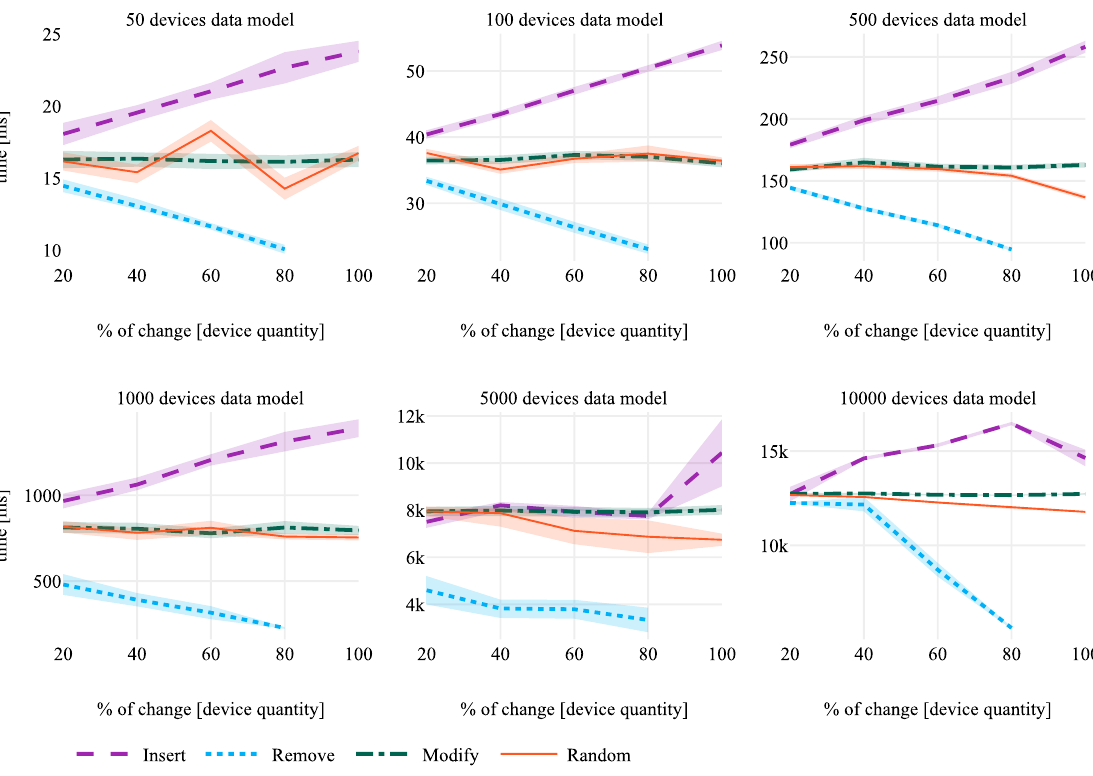
Figure 7. The increase in the percentage of changes in different ICPS Data Model